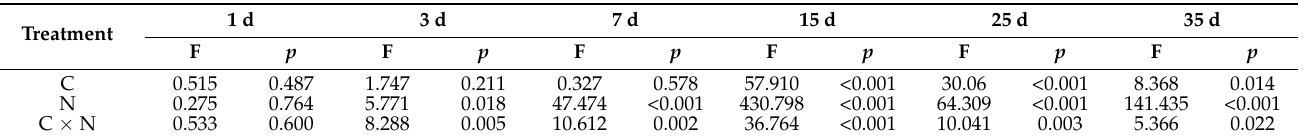
Table 5. ANOVA of the effect of returning straw and the nitrogen application rate on the nitrate nitrogen content in saline soil.